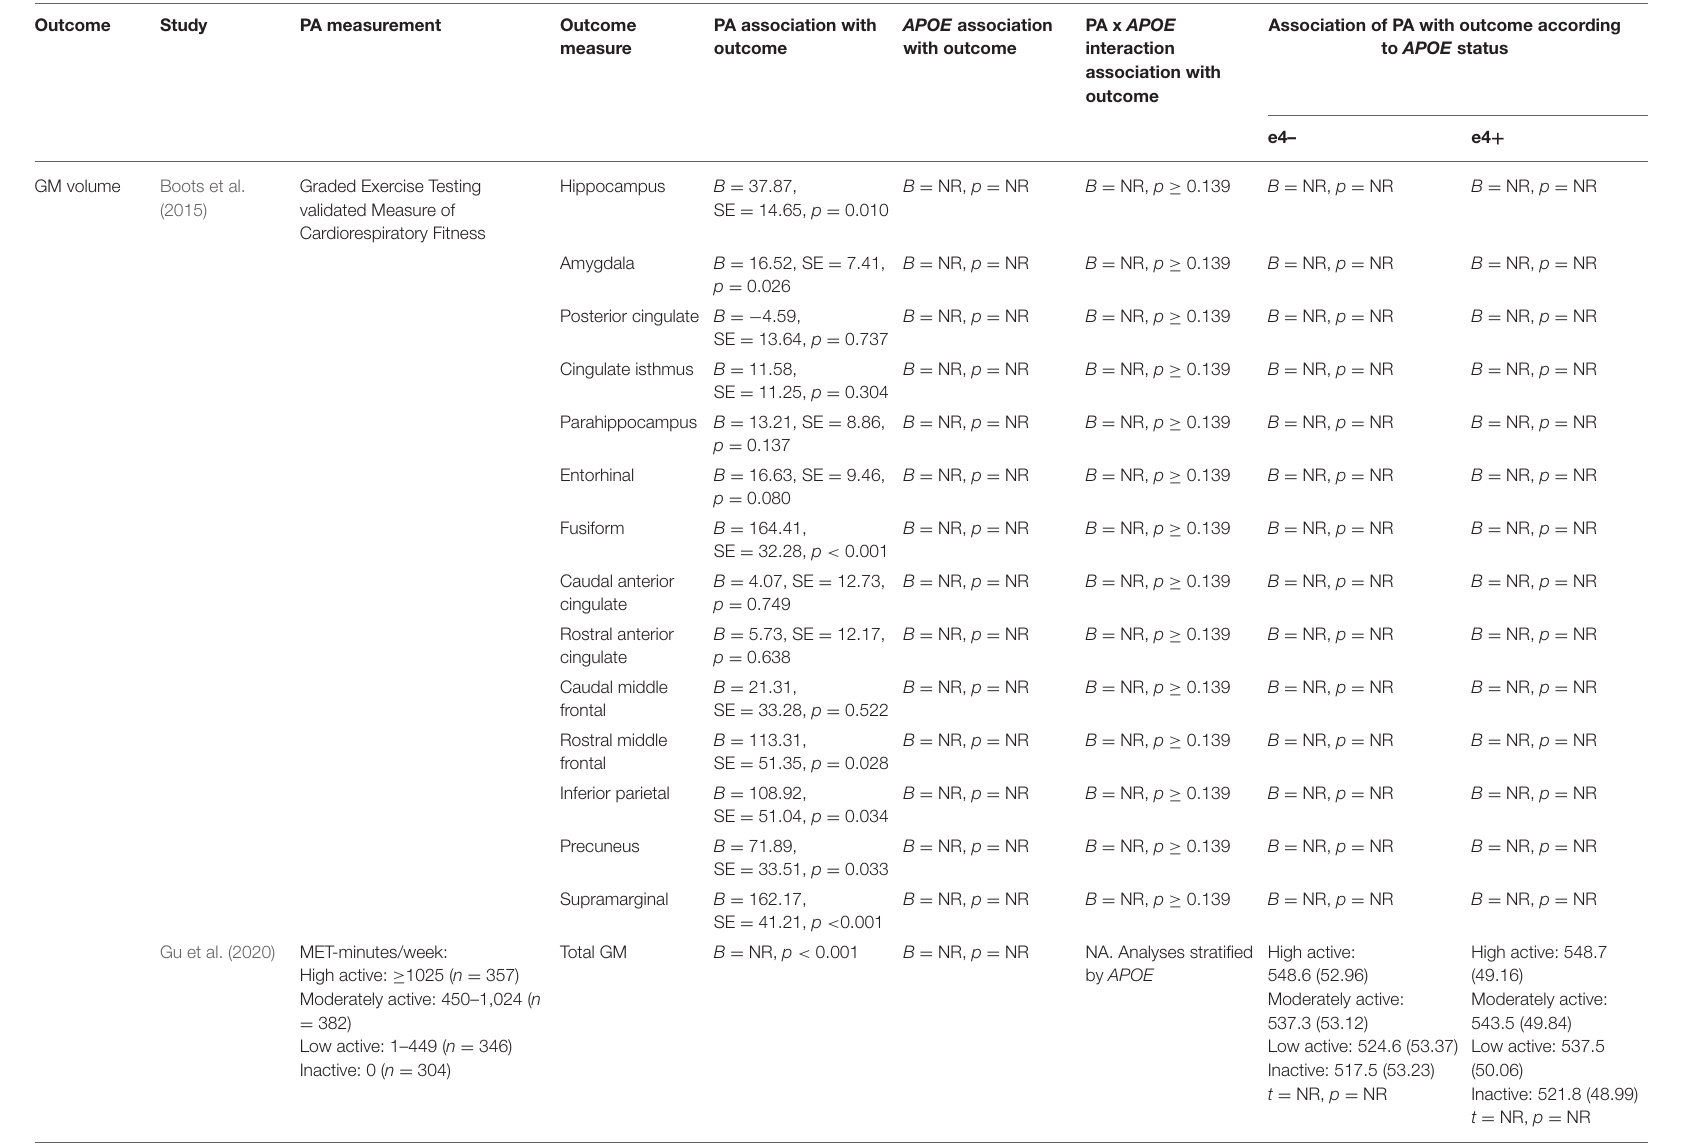
TABLE 4 | Associations between physical activity and brain structure.